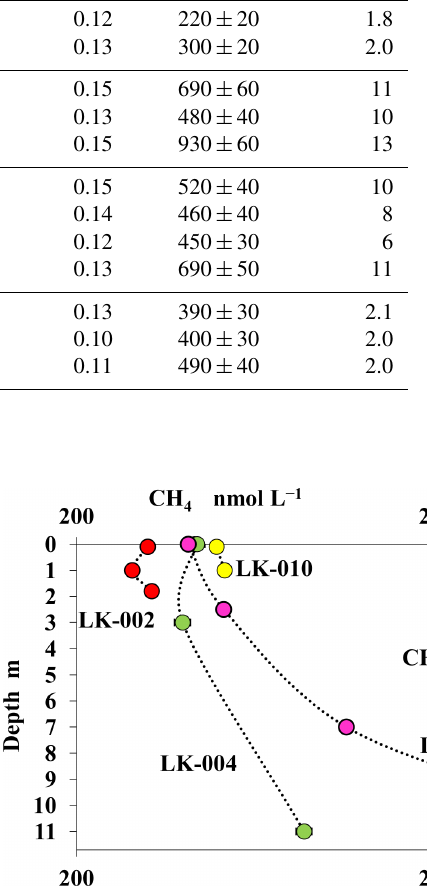
Figure 4. Dark CO 2 assimilation (DCA) in four lakes of the Yamal Peninsula (August 2019) in the water horizons (µgCL − 1 d − 1 ) and integral PP for the entire water column (mgCm − 2 d − 1 ). For all stations, location of the bottom is indicated by a wavy brown band.